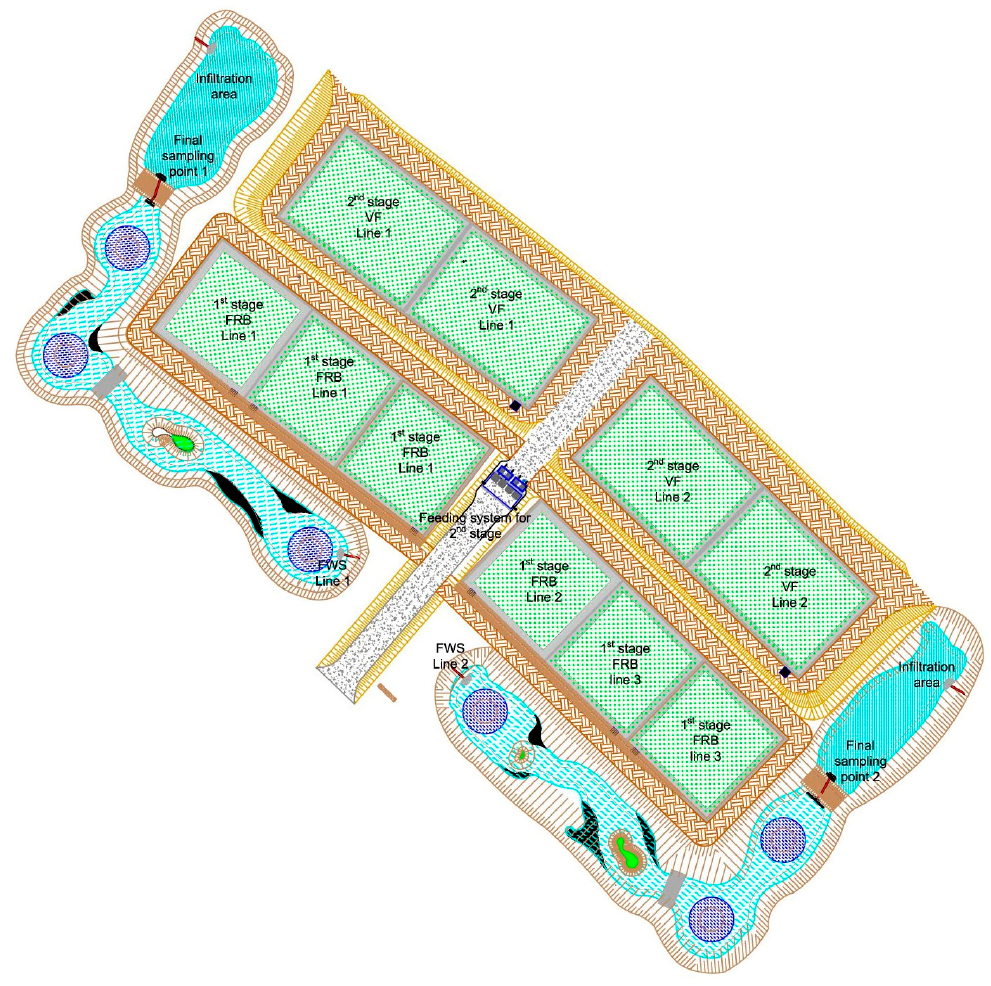
Figure 1. Layout of the French Reed Bed (FRB) wastewater treatment plant (WWTP) of Castelluccio di Norcia (Italy). Note that preliminary treatments, equalization tank, and syphons are not reported in the layout because they are sited farther from the WWTP. Table 1. Technical specifications of the two stage CW WWTP of Castelluccio di Norcia.